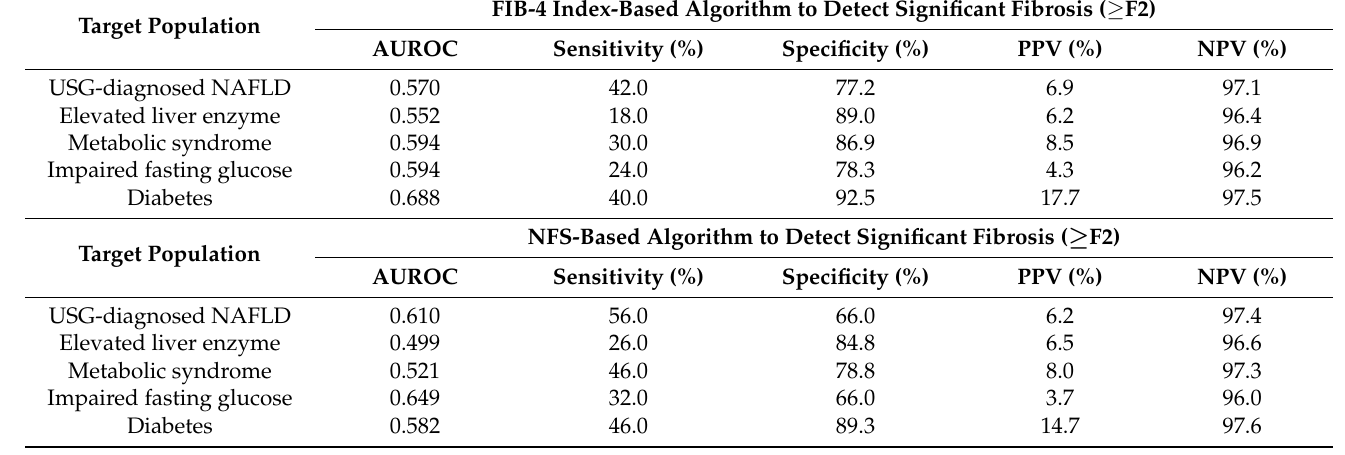
Table 2. Performance of FIB-4 index and NFS based on various